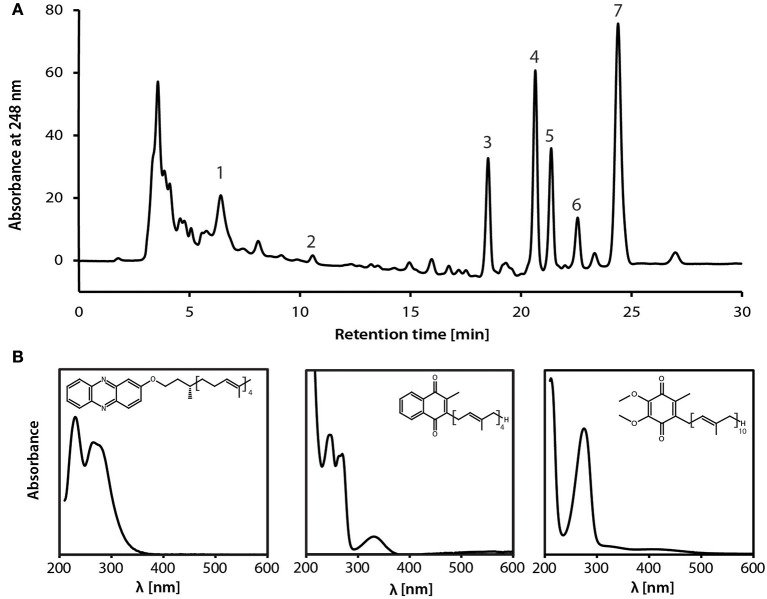
Analysis of the lipid-soluble electron carriers of the nitrate-AOM enrichment culture. (A) HPLC elution profile as visualized by the absorption at 248 nm. Numbers indicate the peaks that were further characterized by UV/Vis spectroscopy. (B) UV-Vis spectra of standard compounds (left, methanophenazine; middle, menaquinone-4; right, ubiquinone-4) for comparison with spectra obtained from fractions separated by HPLC. Based on the comparison of the experimental spectra to the spectra obtained from the HPLC fractions, the different peaks were assigned to contain a representative from the classes of ubiquinones, menaquinones, or methanophenazines. None of the spectra resembled the standard spectrum for methanophenazine (left), seven spectra (obtained from peaks 1, 3, 4, 5, 6, 7,) resembled the standard spectrum of menaquinone-4 (middle) and one spectrum (obtained from peak 2) resembled the standard spectrum of ubiquinone-4. Different retention times within one molecule class indicate a difference in the prenoid chain length. Experimental spectra are displayed in Supplementary Figure S2.